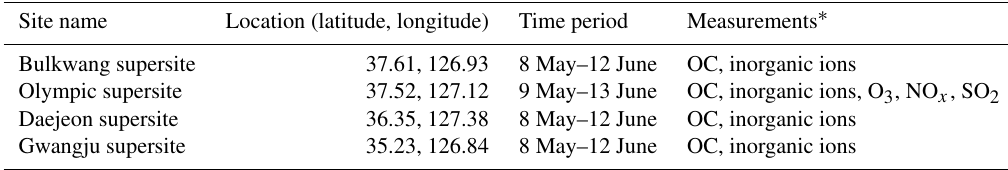
Table 1. List of KORUS-AQ campaign observation sites.